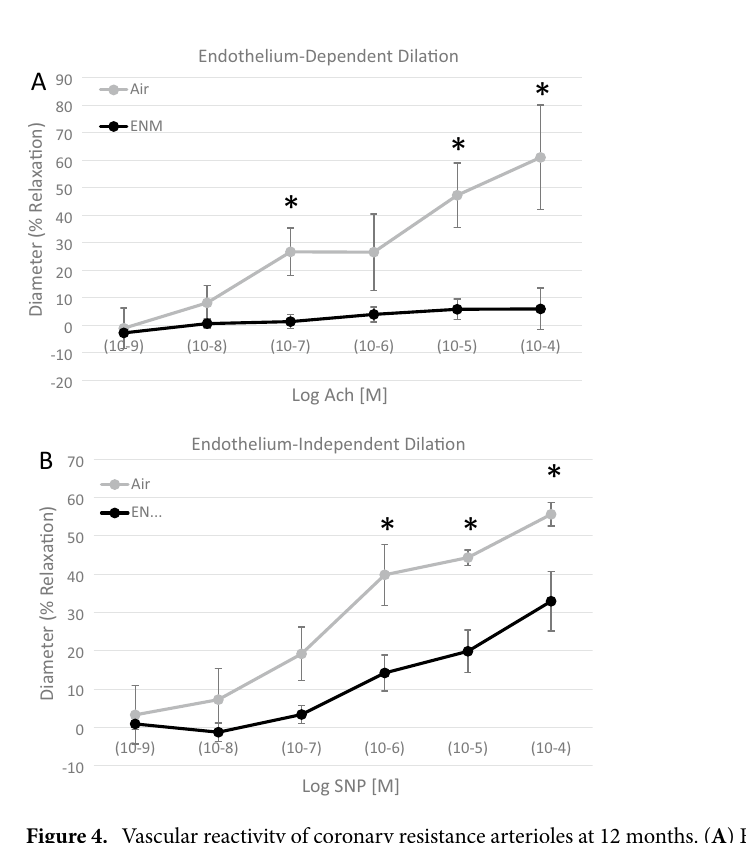
Figure 4. Vascular reactivity of coronary resistance arterioles at 12 months. ( A ) Endothelium-dependent dilation of coronary arterioles from Sham-Control and nano-TiO 2 -exposed animals at 12 months was determined using pressure myography. ACh, Acetylcholine. ( B ) Endothelium-independent dilation of coronary arterioles from Sham-Control and nano-TiO 2 -exposed animals at 12 months was determined using pressure myography. SNP, Sodium nitroprusside. Values are shown as mean ± SEM. n = 4–5. Statistics were analysed with two-way ANOVA., *Indicates p ≤ 0.05 versus Sham-Control (AIR)